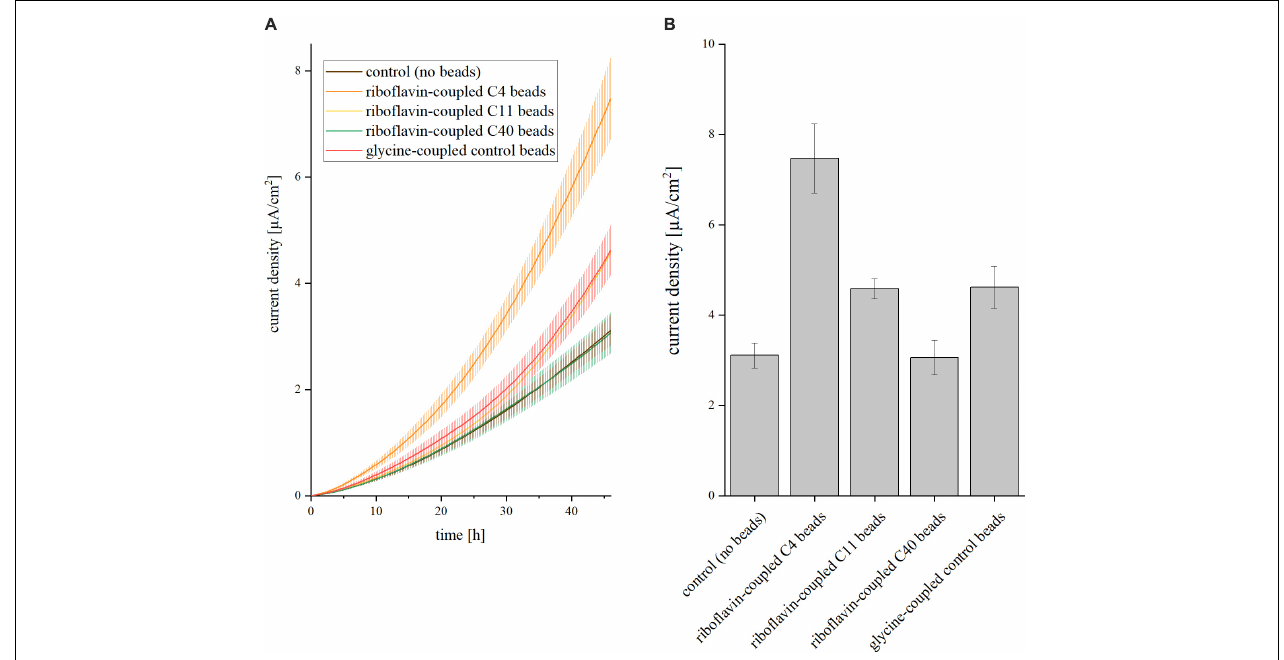
FIGURE 2 | Impact of riboflavin coupled beads on current density in BES. Three different linker molecules characterized by short (C4), medium (C11), and long (C40) chain length were placed between beads and the riboflavin molecule. The control experiment was conducted without addition of riboflavin or magnetic beads; C4/C11/C40 represent the addition of riboflavin-coupled beads with the respective linker chain lengths; glycine instead of a riboflavin molecule was added to the C4 linker in the glycine-coupled control beads. The concentration of riboflavin was 37 nM in all experiments. (A) Current density over 46 h. Error bars represent the standard deviations from means of samples taken in independent triplicates. (B) Average current density after 46 h of operation. Error bars represent the standard deviations from means of samples taken in independent triplicates.